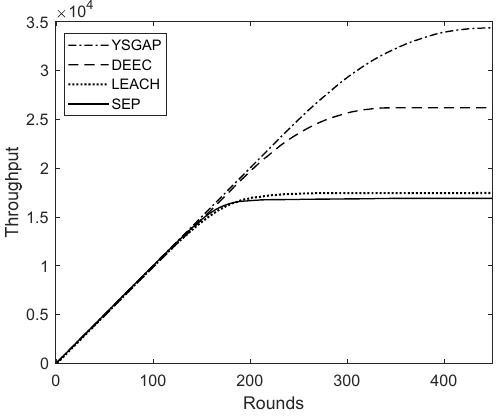
Figure 7. Throughput: total number of packets sent to the BS.